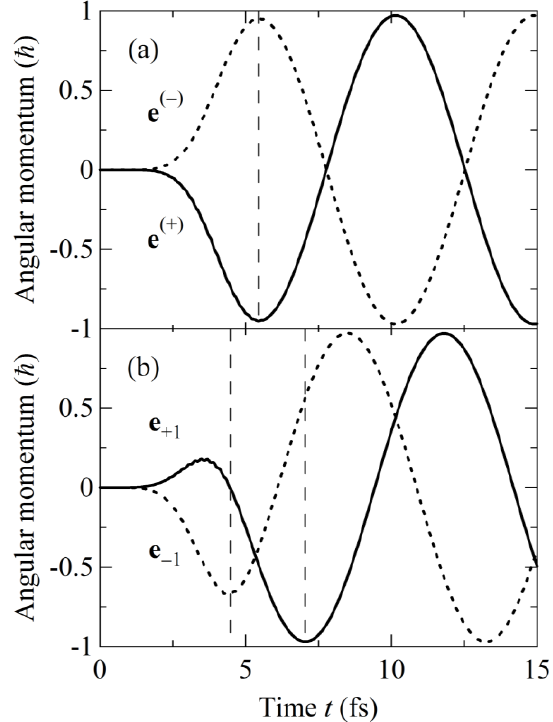
Figure 3. Expectation value of the electronic angular momentum l z ( t ) in DCP irradiated by ( a ) linearly and ( b ) circularly polarized vacuum UV (VUV) laser pulses calculated from electronic WP simulations at the optimized geometry of G . In panel ( a ), the expectation values for e (+) and e (−) are denoted by the solid and dotted lines, respectively. The peaks at t = 5.4 fs are indicated by the vertical broken line. In panel ( b ), the expectation values for e +1 and e −1 are denoted by the solid and dotted lines, respectively. The peaks at t = 4.5 and 7.0 fs are indicated by the vertical broken lines. The laser pulses fully decay at t = 7.26 fs. Modified from [58] with permission of the Physical Society of the Republic of China.